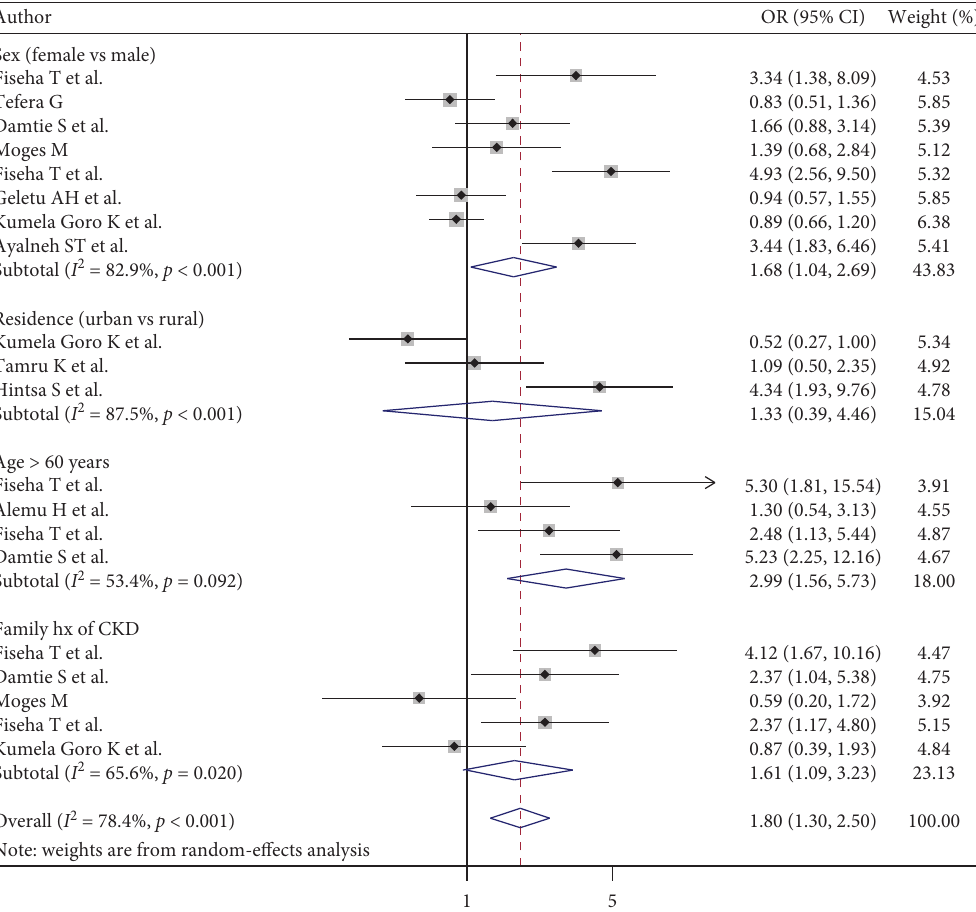
Figure 5: Sociodemographic factors associated with CKD in patients with